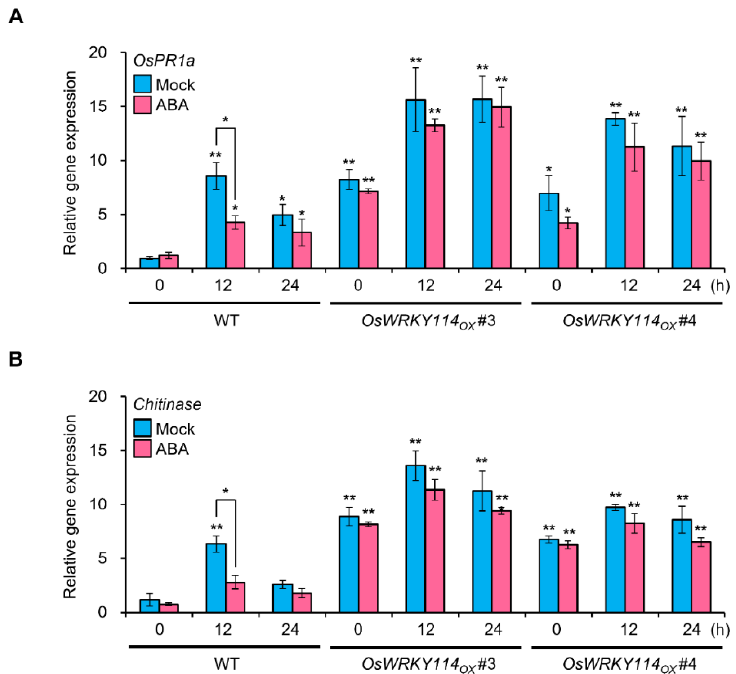
Figure 2. The expression levels of PR genes regulated by OsWRKY114 are not suppressed by ABA in OsWRKY114 -overexpressing plants during Xanthomonas oryzae pv. oryzae infection. ( A , B ) Relative transcript levels for OsPR1a ( A ) and chitinase ( B ), as determined by RT-qPCR. Four-week-old rice plants were pretreated with 100 µ M ABA or mock solution. Three days later, leaves were inoculated with Xoo and collected after the indicated incubation times. cDNA was synthesized from total RNA in rice leaves. OsActin was used as an internal control. Data are shown as means ± SD. * p < 0.05, ** p < 0.01, determined by t -test relative to the 0 h mock-treated wild-type sample and between the indicated comparing samples.